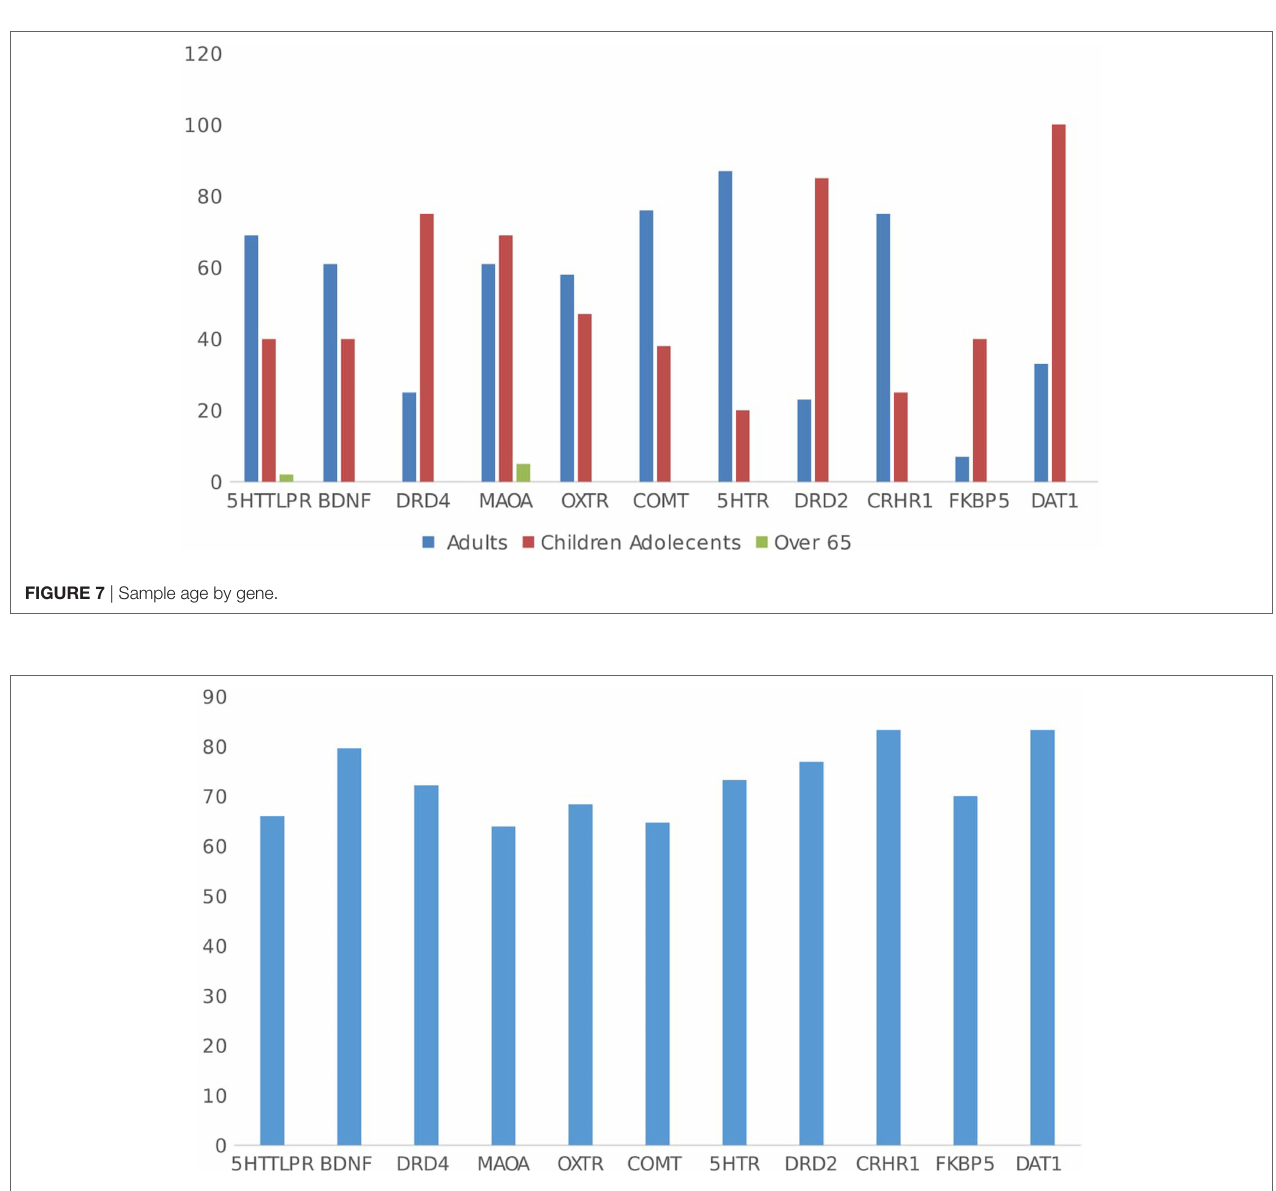
FiGURe 8 | Percentage of gene–environment interactions with positive findings by gene.